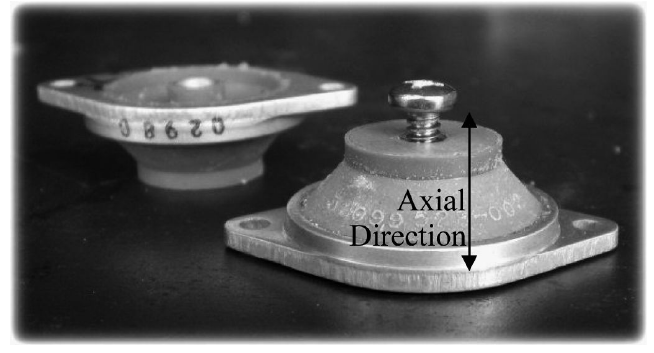
Fig. 4. Typical vibration isolator often used in commercial 1D TDA